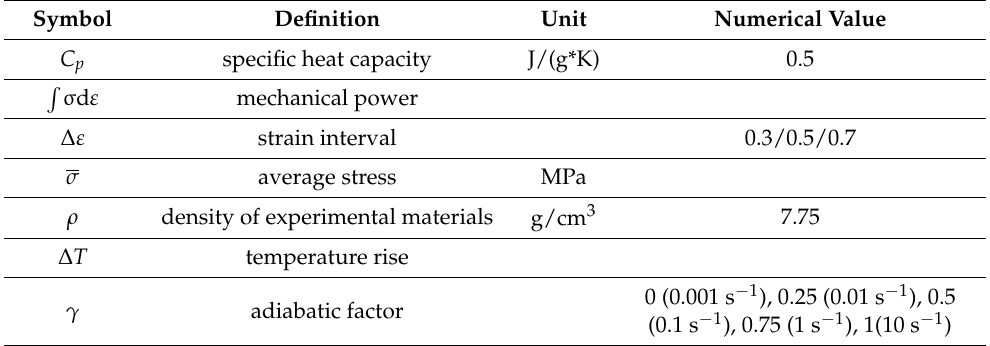
Table 4. Parameter table of adiabatic